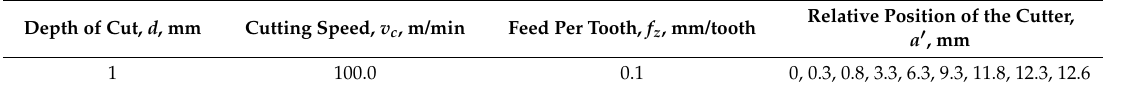
Table 3. Specifications of cutting